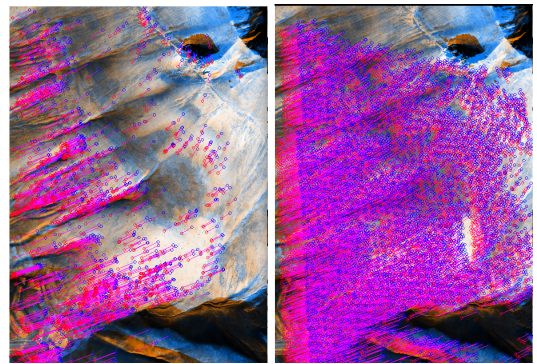
Figure 18. Tie point extraction on diachronic satellite image pair. Left: with SIFT, right: with the proposed method.